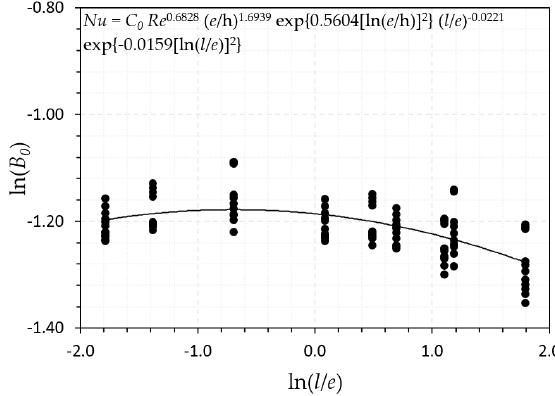
Figure 17. Plot of ln ( 𝐵 (cid:2868) ) as function of ln ( l / e ).